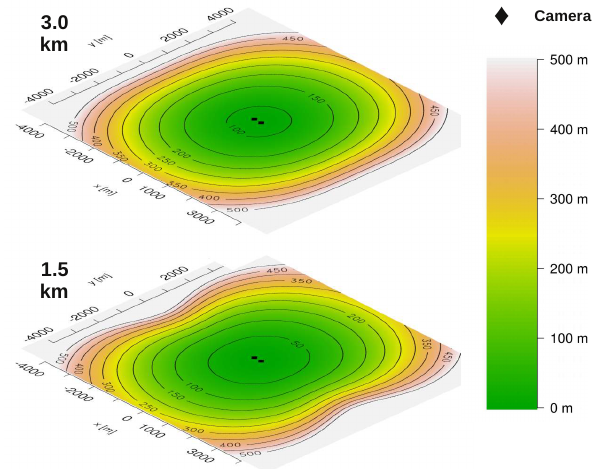
Figure 11. Errors in the disparity values cause a directional devia- tion of the projection rays within the epipolar plane. Assuming an error of (cid:49)ψ R = 0 . 1 ◦ , we can compute the absolute geometric error within the epipolar plane for a hypothetical cloud layer at 1.5 and 3km height in an area of 5km around the cameras.